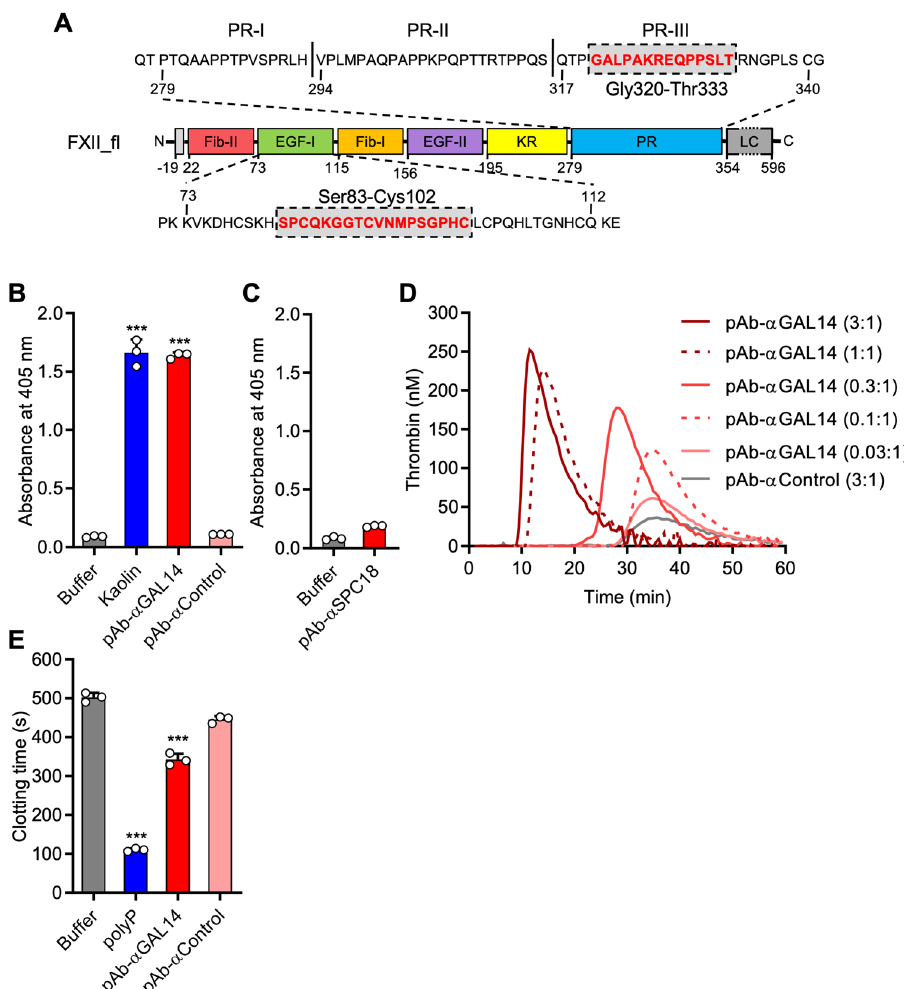
Fig. 6 Polyclonal antibodies against PR-III activate FXII. A Schematic structure of human full-length FXII. Top panel: PR-I, PR-II, and PR-III amino acid sequences are indicated within the PR domain; Bottom panel: sequence of the EGF-I domain. The peptide sequences used to raise the polyclonal antibodies pAB- α GAL14 (Gly320-Thr333) and pAB- α SPC18 (Ser83-Cys102) are highlighted in red. Numbers indicate amino acid residues. B FXII_pd was incubated with buffer, kaolin (10 μ g/mL), pAB- α GAL14 (1 μ M) or a control polyclonal antibody (pAB- α Control, 1 μ M). FXIIa formation was measured using S2302. C FXII_pd was incubated with buffer or pAB- α SPC18 (1 μ M) and FXIIa formation was measured using S2302. D Real-time thrombin generation in normal PPP activated with pAB- α GAL14 or pAB- α Control. Molar ratio antibody:FXII are relative to endogenous FXII levels in normal PPP (375 nM). Representative thrombin generation curves are shown. (E) Clotting times of recalci fi ed normal PPP incubated with buffer, long-chain polyP (25 μ g/mL), pAB- α GAL14 (2 µ M) and/or pAb- α Control (2 µ M). In B , E : ***: P < 0.001 vs. buffer by one-way ANOVA and Dunnett´s multiple comparison test. Columns give means ± SD. For B – E three independent experiments of n = 3 each were